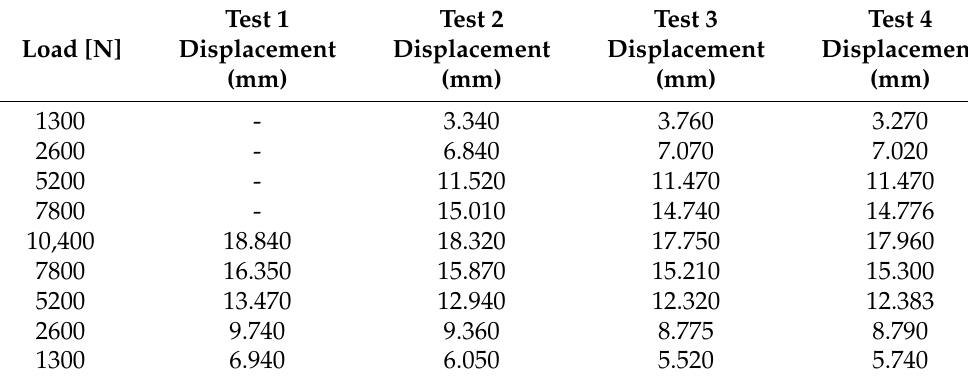
Table 2. Displacement results as a function of the load applied to the stay cable of the mockup tower ( L = 2420 mm).